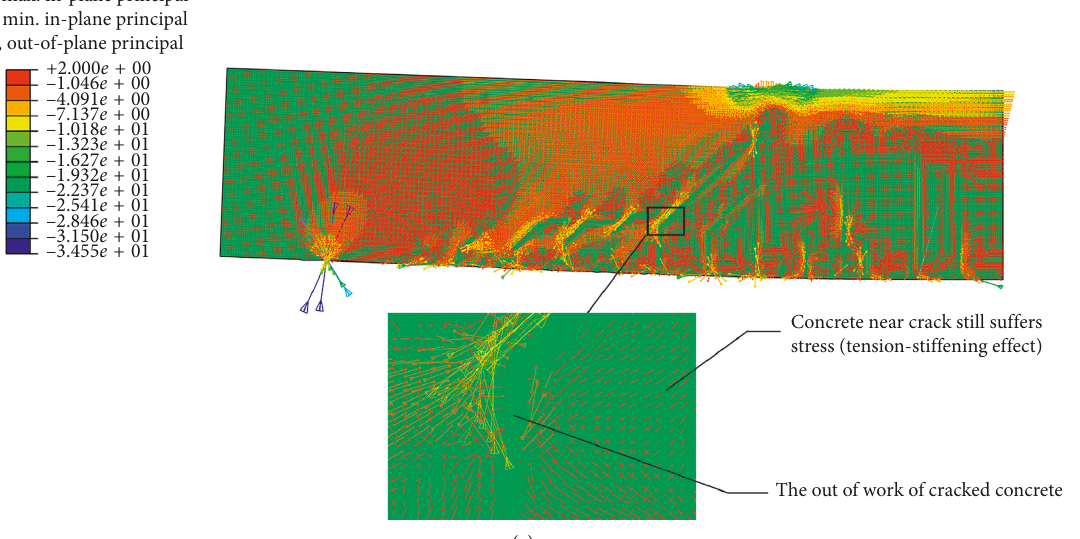
The surging of reinforcement stress at cracks